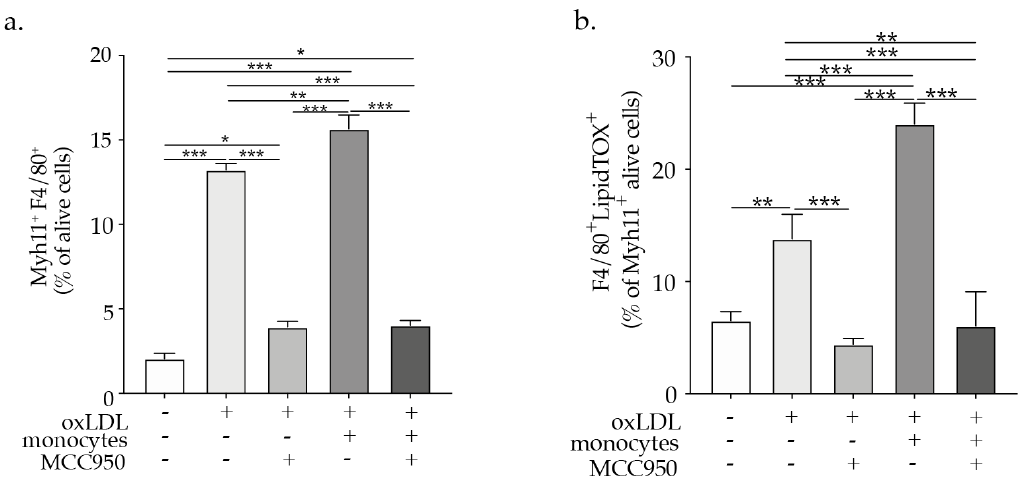
Figure 4. Bars graphs represent the mean ± SEM of ( a ) Myh11 + F4/80 + -expressing VSMCs and ( b ) F4/80 + LipidTOX + (foam cells) formation as a percentage of alive cells as indicated upon oxLDL or monocytes, or oxLDL-activated monocytes supplementation in the presence or absence of MCC950, with n = 6/group and * p < 0.05, ** p < 0.01, *** p < 0.001, one-way ANOVA.